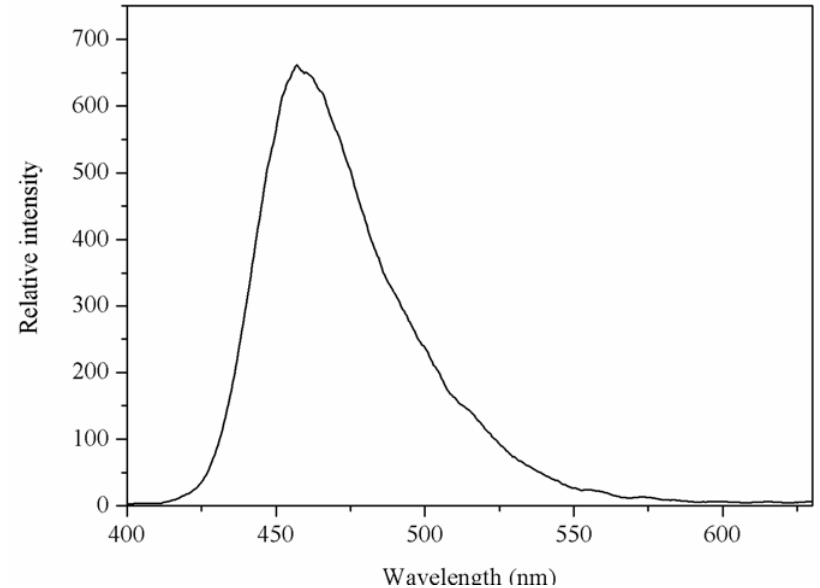
Figure 4. The emission spectrum of Mg(II) complex. The excitation and emission slit widths were 2.5